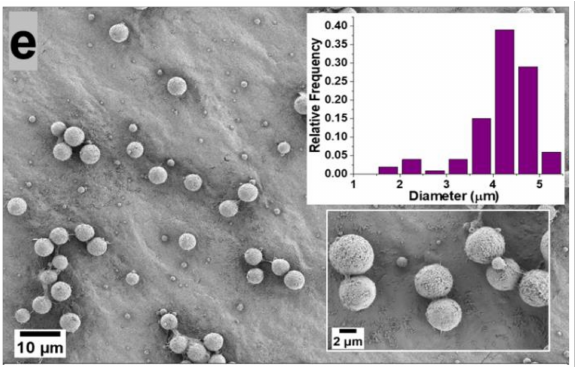
Figure 1. Morphology of the microparticles obtained from 5 wt.% PVDF in DMF/ACE 20:80 ( a ), 40:60 ( b ), 60:40 ( c ), 80:20 ( d ), 100:0 ( e ) polymer solution ( v / v ) using flow rate of 0.3 mL/h. The microparticle distribution obtained from each processing condition is presented as an